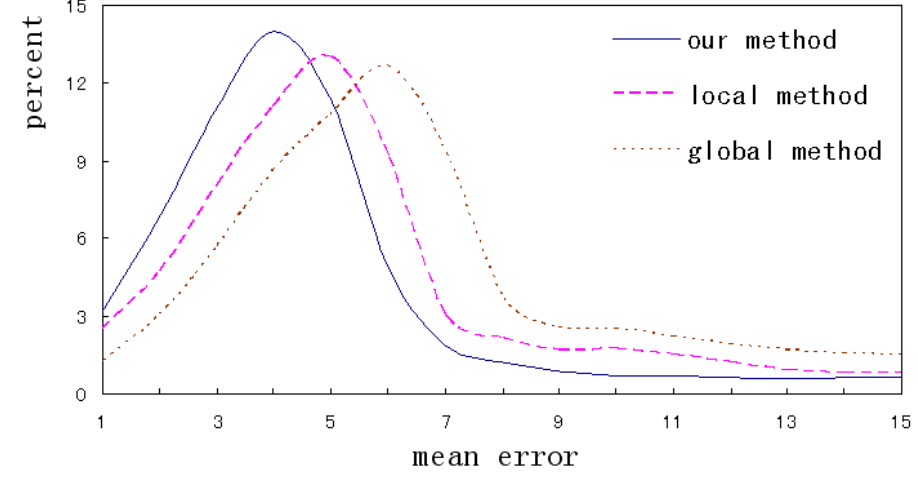
Figure 14. The error distribution of the different methods.